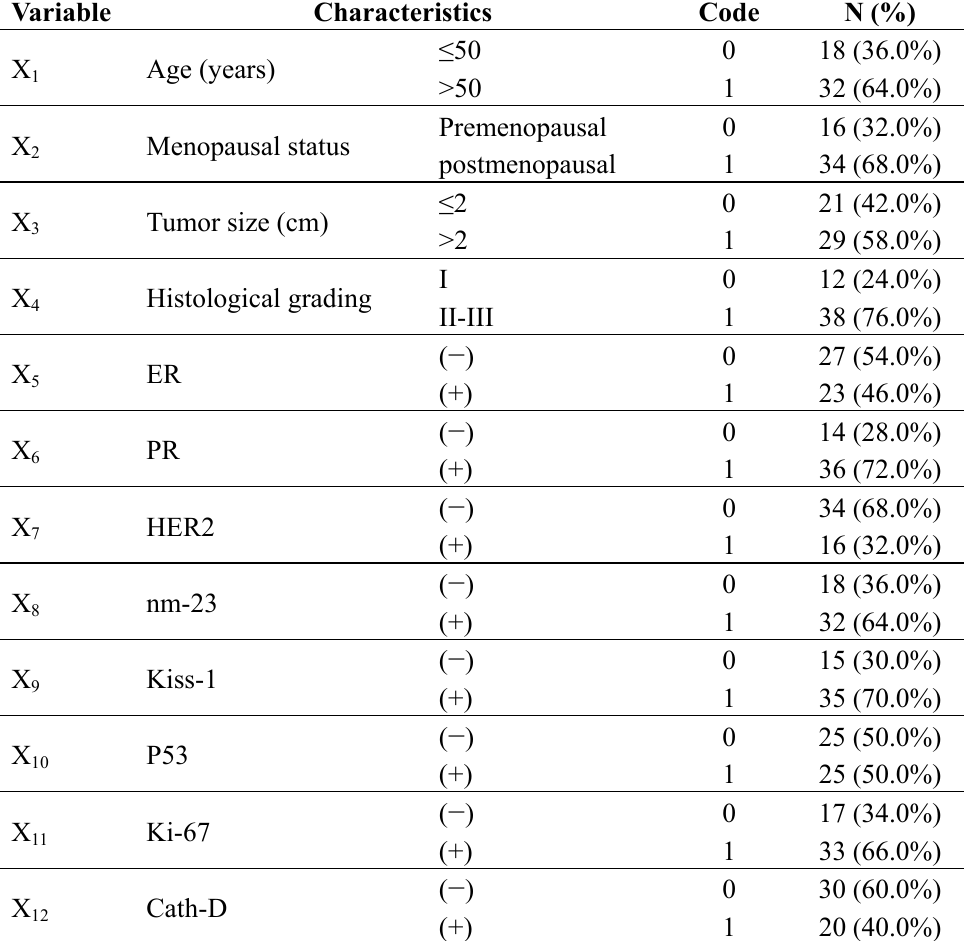
Table 2. Modeling group patients and tumor characteristics (n =